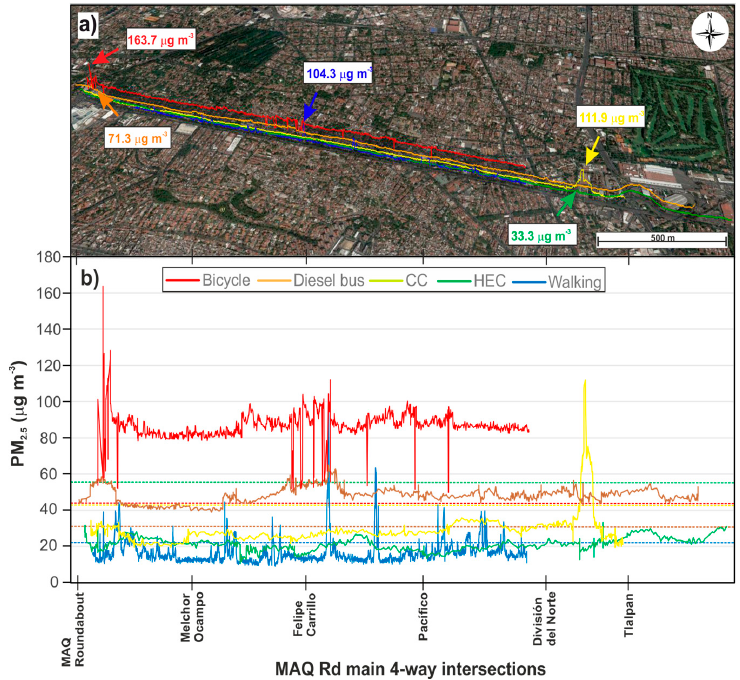
Figure 4. ( a ) Spatial location of PM 2.5 by mode of transport recorded during TAX to MAQ journeys; ( b ) PM 2.5 time series per journey. Street names indicated in the X -axis correspond to 4-way intersections. The horizontal dashed lines show corresponding 1-h averages of PM 2.5 recorded at COY used to calculate exposure